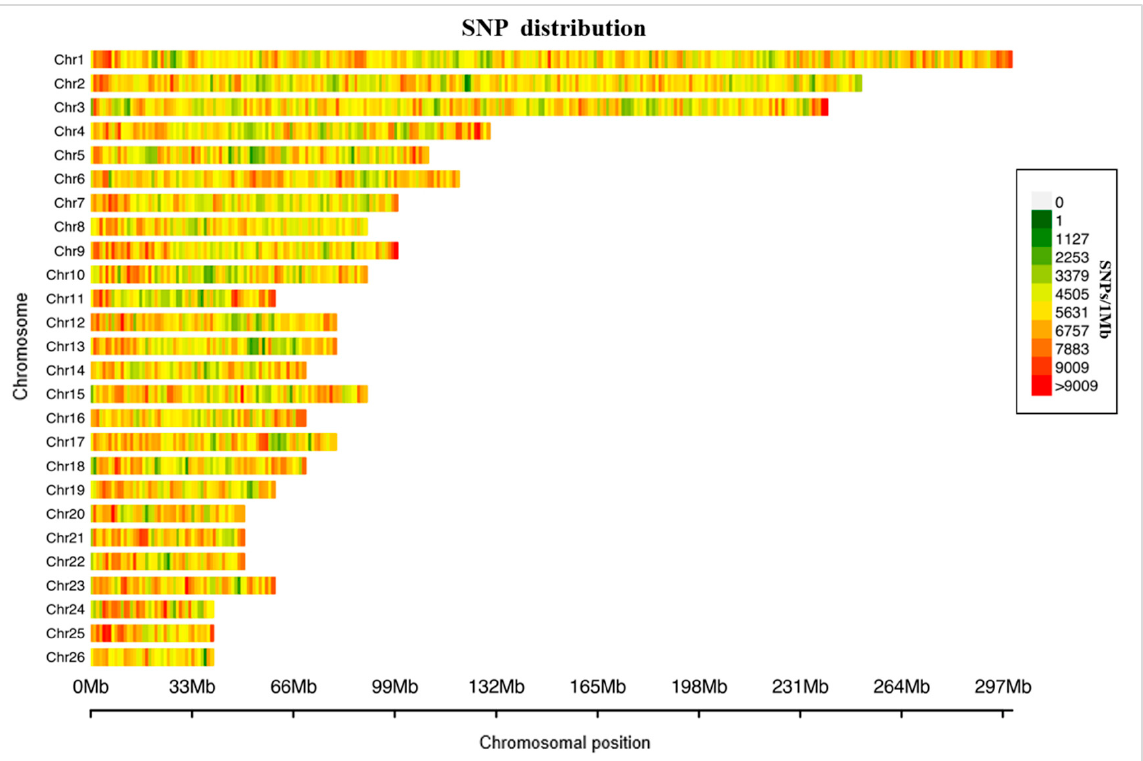
Figure 1. Distribution of the sequenced SNPs on all chromosomes. The y -axis represents chromo- somes, and the x -axis represents the corresponding chromosomal position (Mb). Different colors of each 1-Mb genome block denote the number of SNPs.